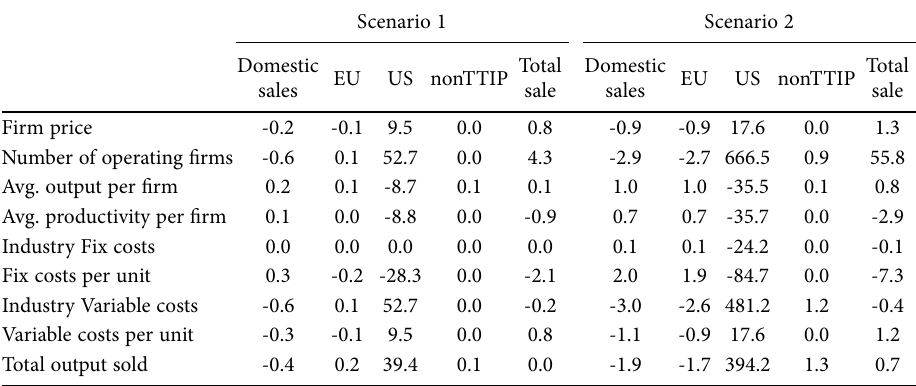
Table 7. Average firm results for EU domestic sales and exports of processed food [%